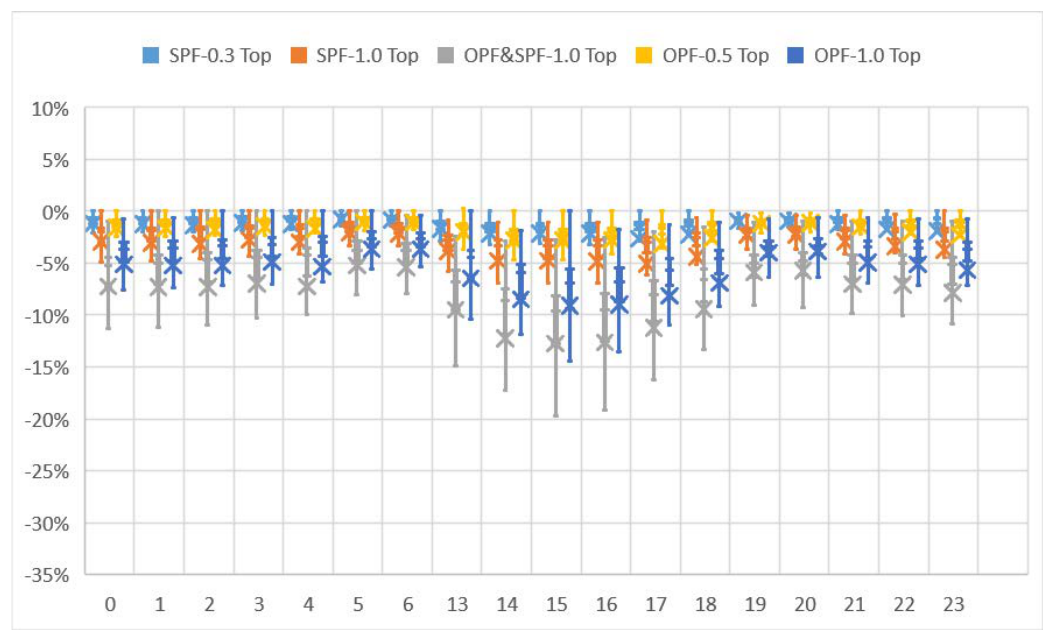
( d ) Box charts for hourly percentage difference in a year for tests for the Top Floor, (1) Infiltration decreased to 0.3 ach; (2) Infiltration decreased to 0.6 ach; (3) Window-to-Wall Ratio reduced to 14.9%.